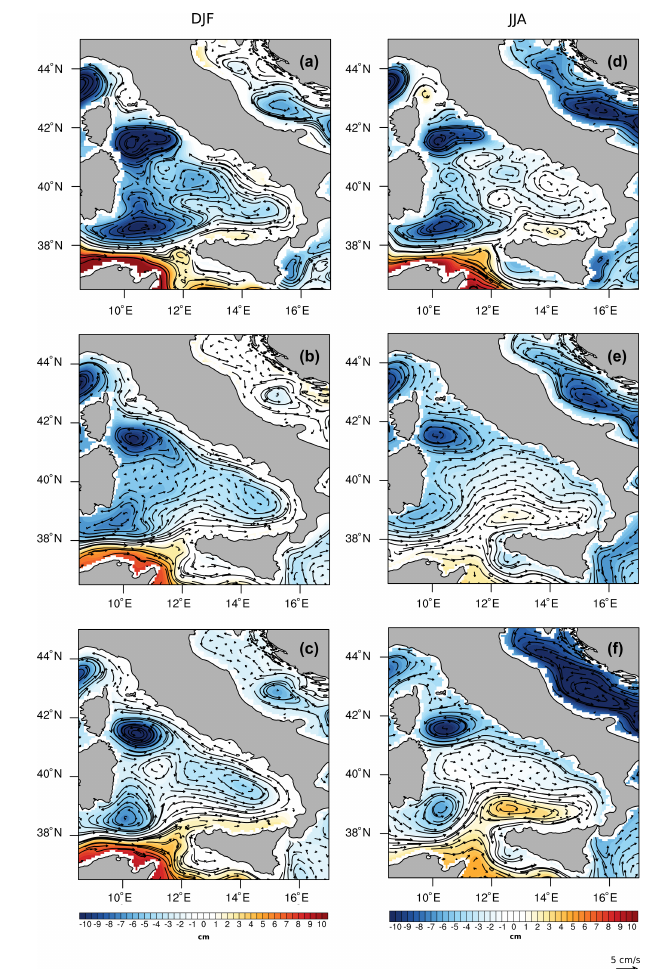
Figure 3. Winter (a–c) and summer (d–f) averages of geostrophic circulation (arrows, cms − 1 ) and sea-surface height (SSH, colors, cm) computed (a, d ; 1993–2005 ) from AVISO, (b, e) present-day reference period (1976–2005) and (c, f) future (2070–2099) with